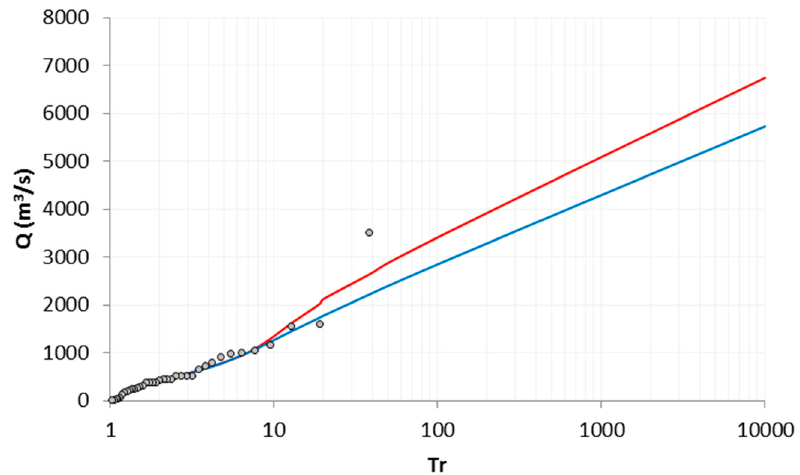
Figure 15. Design values of gaging station 10031 using the parameters computed in the EV1-3P by ML ( ) and HS ( ).